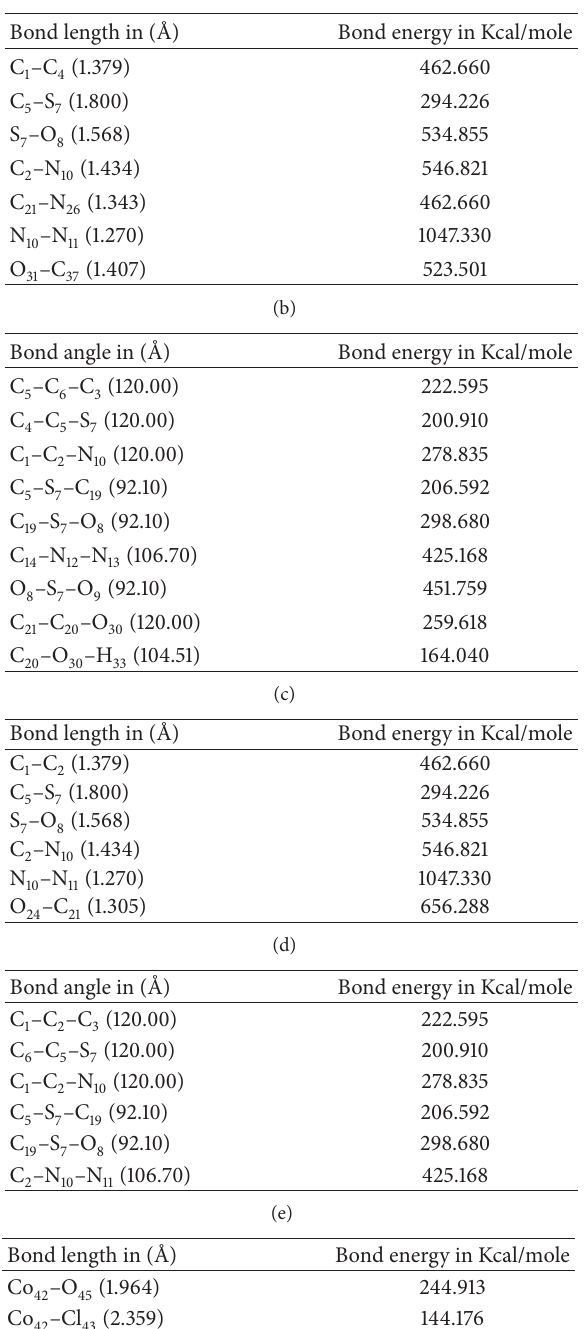
Table 3: (a) Selected bond lengths and bond energies of the ). (b) Selected bond angles and bond energies of the ligand (LH 2 ). (c) Selected bond lengths and bond energies of the ligand (LH 2 ). (d) Selected bond angles and bond energies of the ligand (L 󸀠 H 2 ). (e) Selected bond lengths and bond energies of ligand (L 󸀠 H 2 LCl (H O) ] complex. (f) Selected bond angles and bond the [Co 2 2 2 6 energies of the [Co